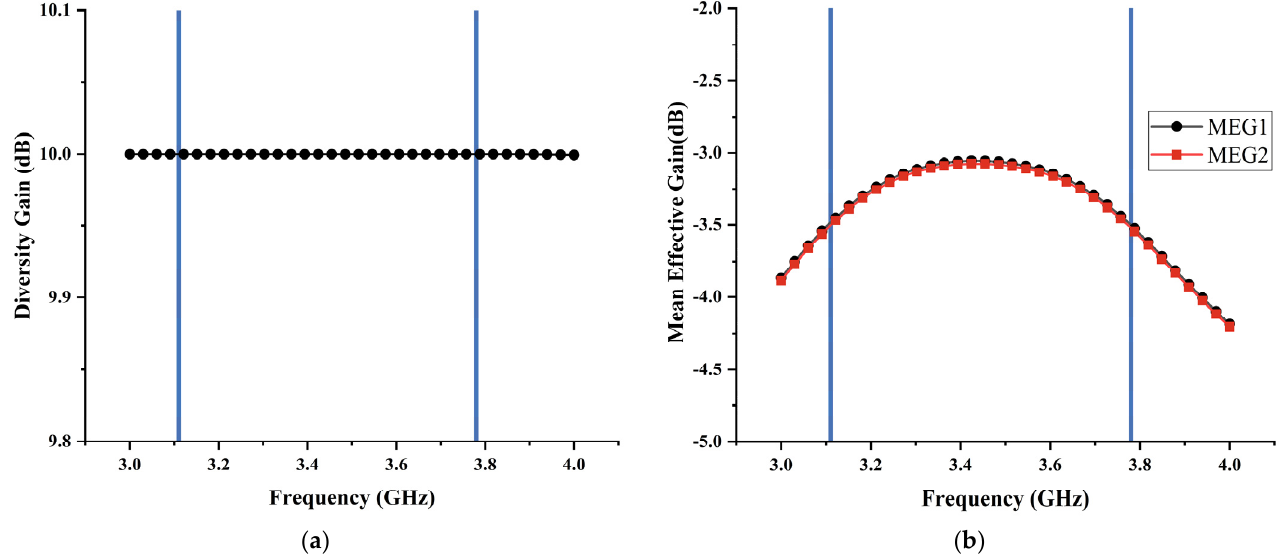
Figure 22. ( a ) The calculated DG; ( b ) The calculated MEG.